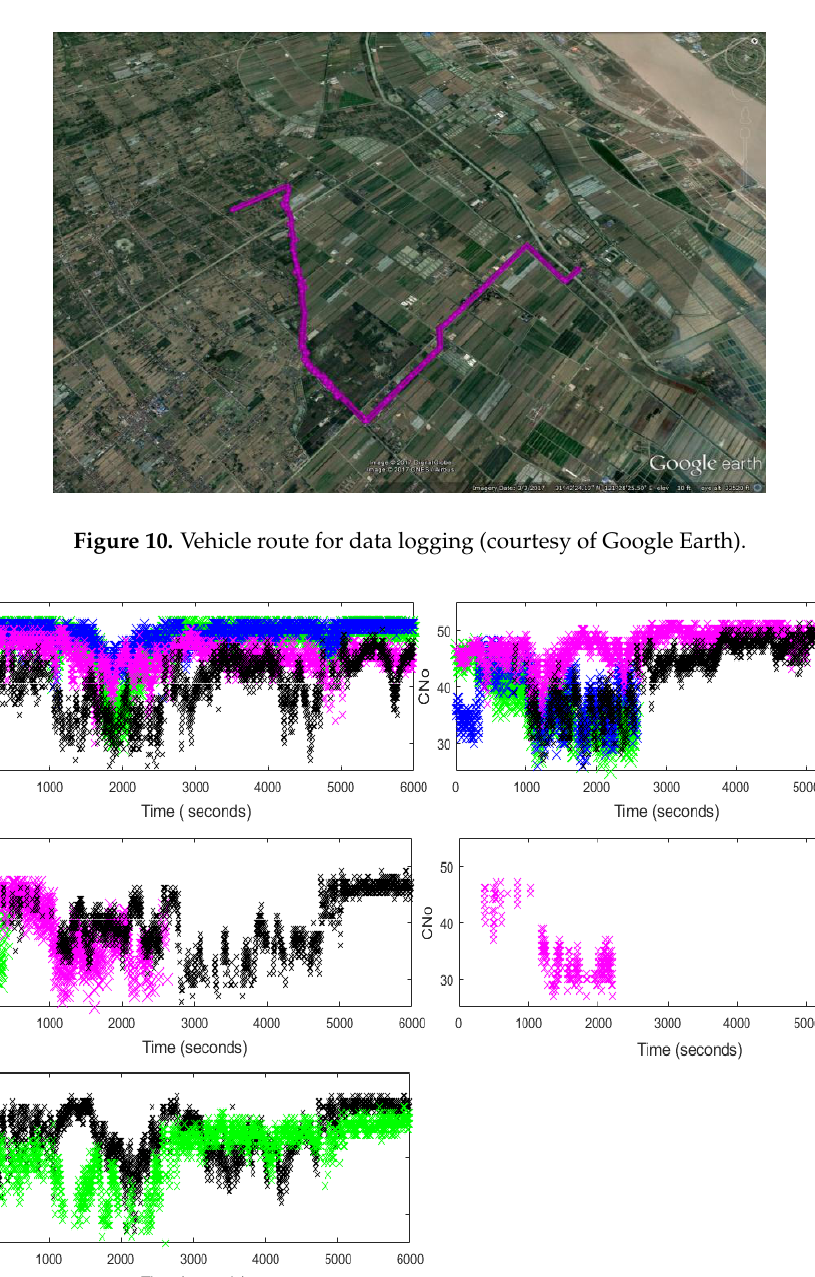
Figure 11. CNo of visible GPS satellites.